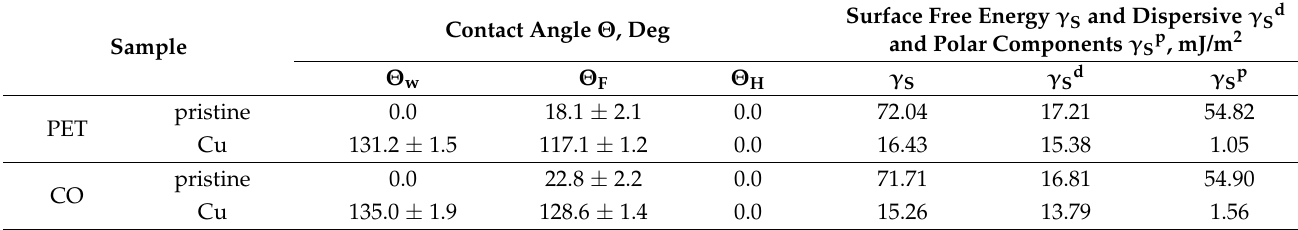
Table 6. The values of the contact angle and surface free